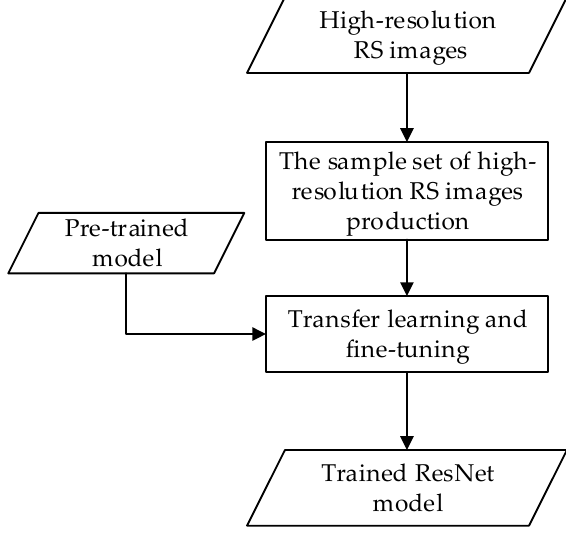
Figure 3. Training process of the ResNet model.